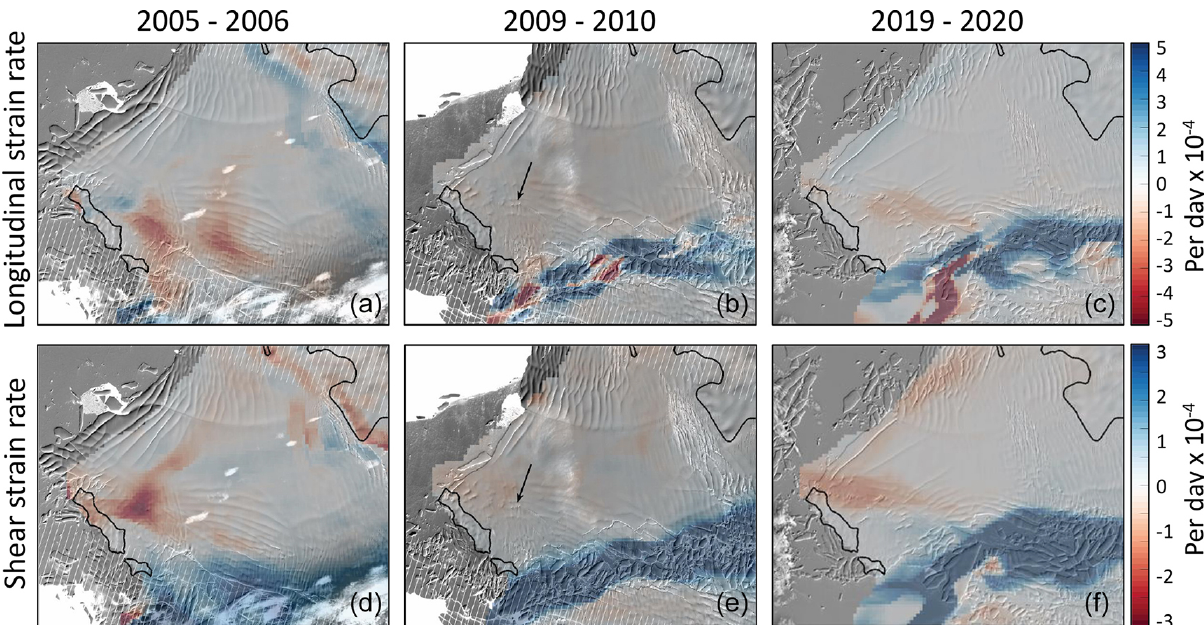
Figure 7. Mean longitudinal strain rates (a–c) and shear strain rates (d–f) , from MODIS feature tracking in 2005–2006 during the TEIS acceleration event (a, d) , 2009–2010 (b, e) , and 2019–2020 (c, f) . The TEIS–TWIT shear margin is near the bottom of each image and the TEIS shear zone is to the right of the twin “islands” of the pinning point, outlined in black, from the MEaSUREs 2011 grounding line (Rignot et al., 2016). Background images are from Landsat-7 ( a, d : 13 January 2005; b, e : 13 December 2010) and Landsat-8 ( c, f : 12 November 2019). The first major crevasses within the location of the current shear zone became visible in Landsat imagery around 2010, and examples are indicated by the arrows in the middle